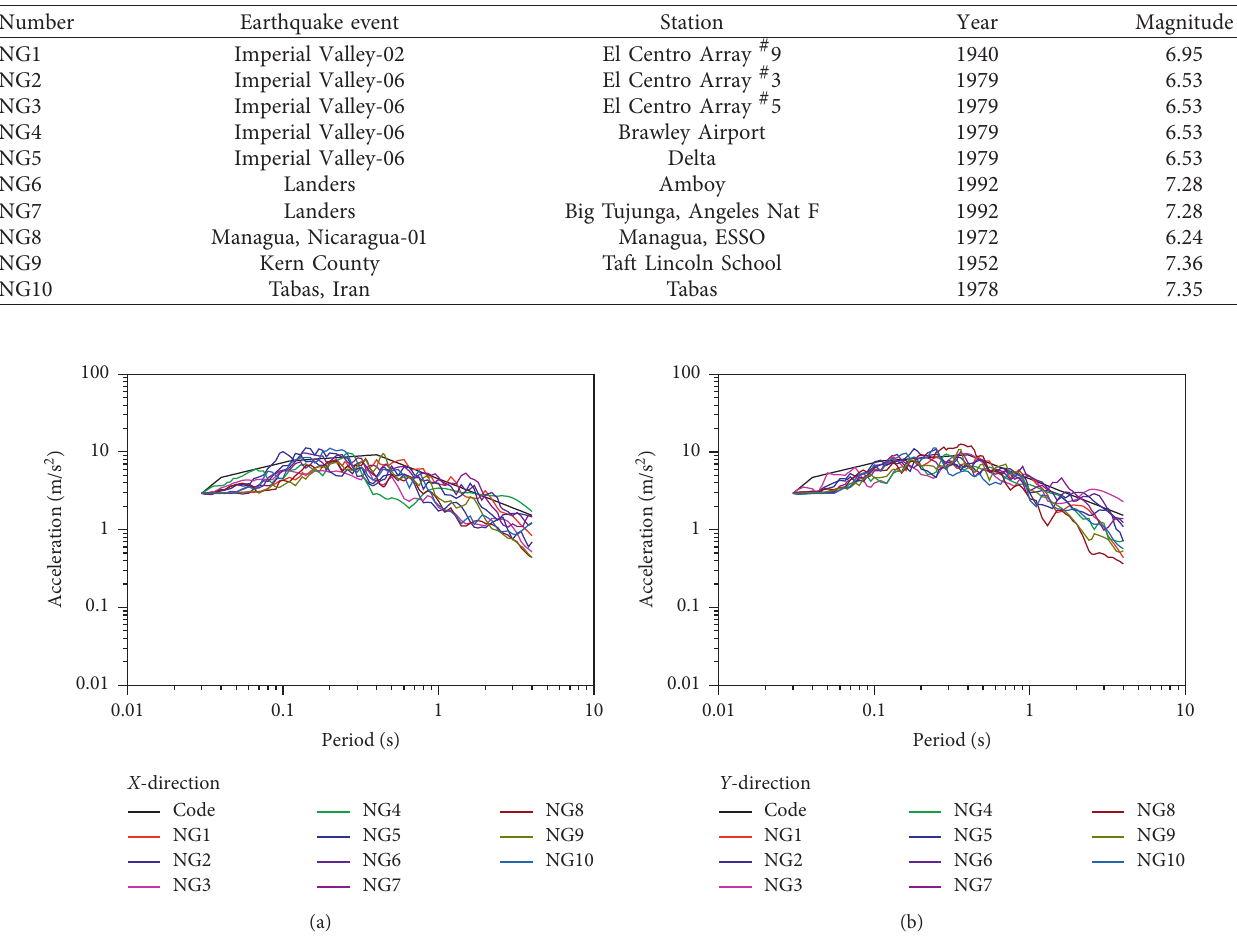
Figure 11: Comparison of peak relative displacement along the height of structure: (a) X -direction, (b) Y -direction, and (c) Z -direction. Table 5: Parameters of ten natural ground motions.